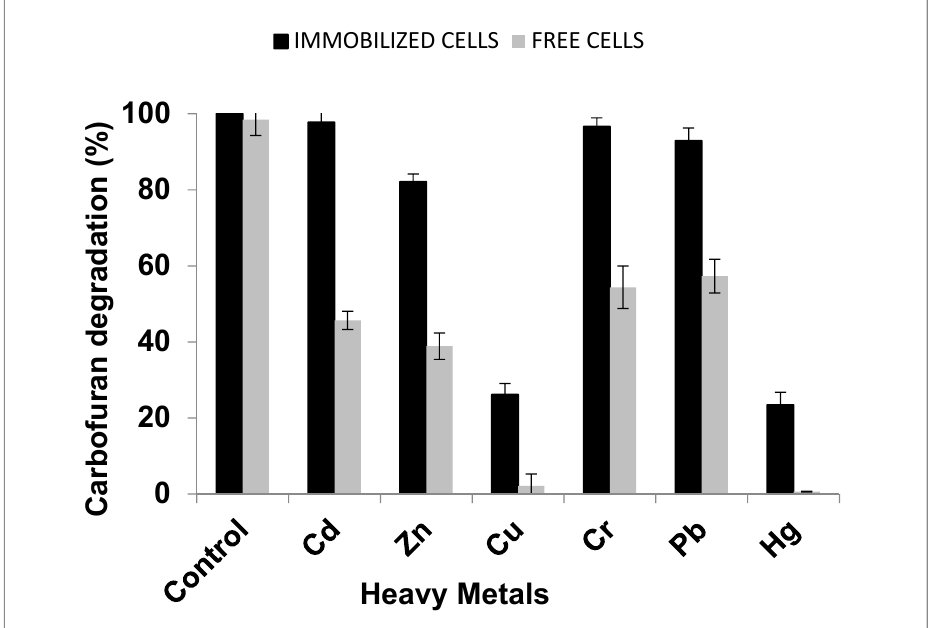
Figure 2. The e ff ect of di ff erent heavy metals on the degradation of carbofuran by the immobilized and Figure 2. The effect of different heavy metals on the degradation of carbofuran by the immobilized free cells of Enterobacter sp. Data represent mean ± STDEV, n = and fr ee cells of Enterobacter sp. Data represent mean ± STDEV, n = 3.